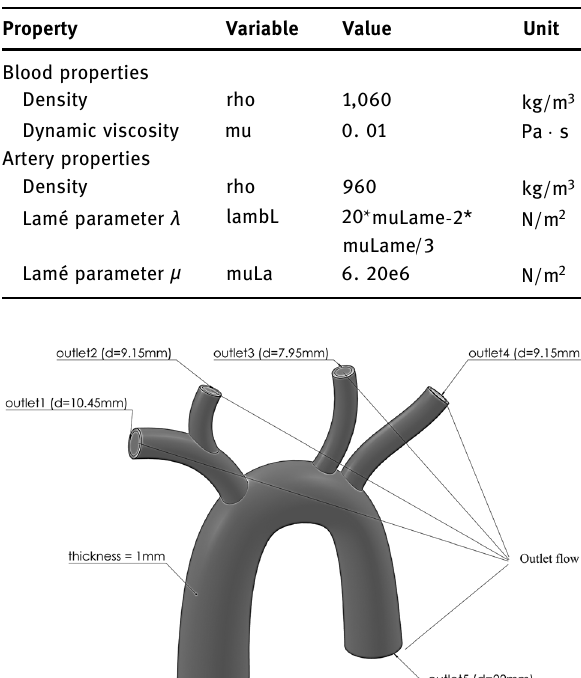
Table 1: Mechanical properties of the blood and arteries